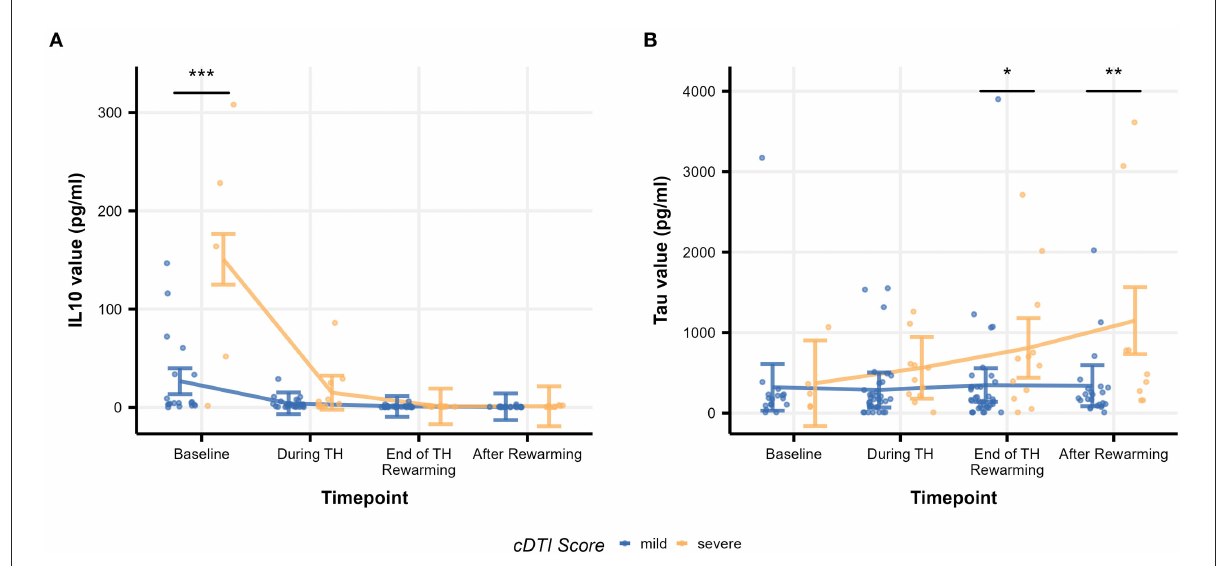
FIGURE5 Time courses of biomarker values [ (A) : IL-10 and (B) : tau] by severity group. Raw biomarker values are shown as scatterplots, and time courses are indicated as error bars. The error bars on each timepoint (baseline, during TH, end of TH/rewarming, and after rewarming) were calculated based on the results of the mixed-model analysis. Significance stars are embedded according to the result of the post-hoc t -test ( * p < 0.05, ** p < 0.01, and *** p < 0.001).